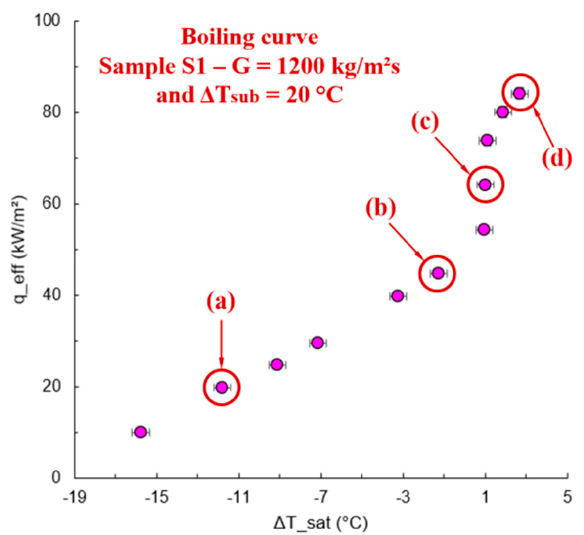
◦ 2 s and ∆ T sub = 20